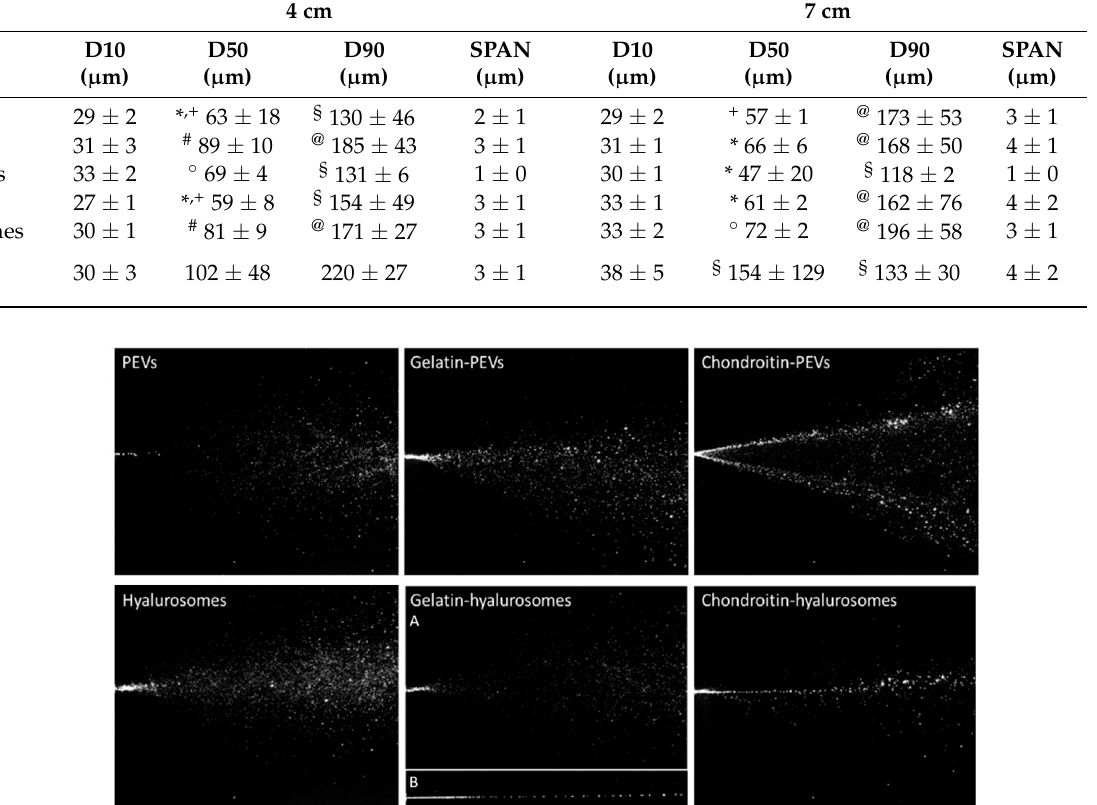
Table 2. Average diameter of droplets generated by spraying C. halicacabum extract-loaded PEVs, gelatin-PEVs, chondroitin- PEVs, hyalurosomes, gelatin-hyalurosomes, and chondroitin-hyalurosomes, and measured using Spraytec ® . Mean values ± standard deviations of three measurements were reported. The same symbol (*, § , + , # , ◦ , @ ) indicates the same value.